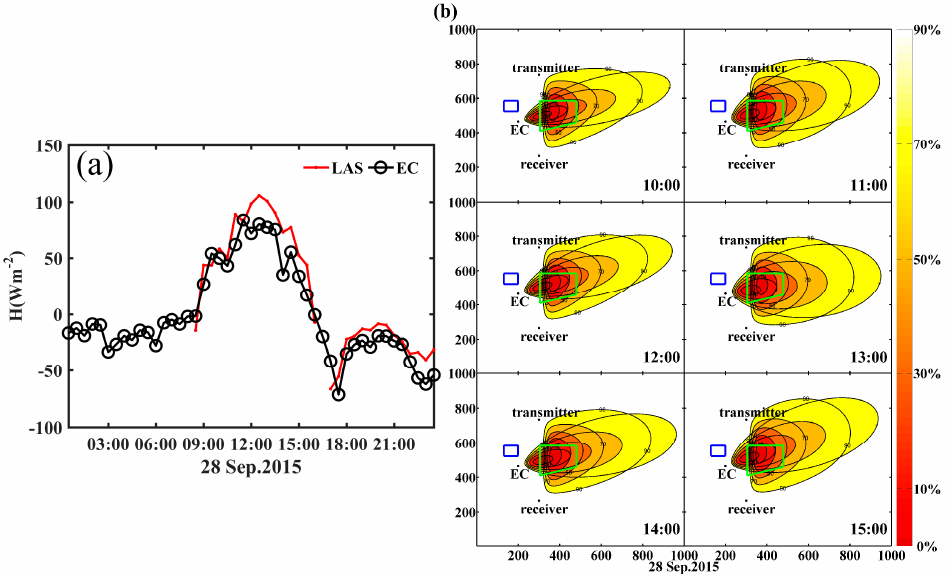
Figure 11. Variations of H LAS and H EC on 28 September were shown in ( a , b ) Footprints of sensible heat fluxes measured by the EC and LAS systems on 28 September. The blue rectangle represents the grove, and the green trapezoid represents the mulberry seedling field. Additionally, the corresponding time is marked in the lower right corner of picture.